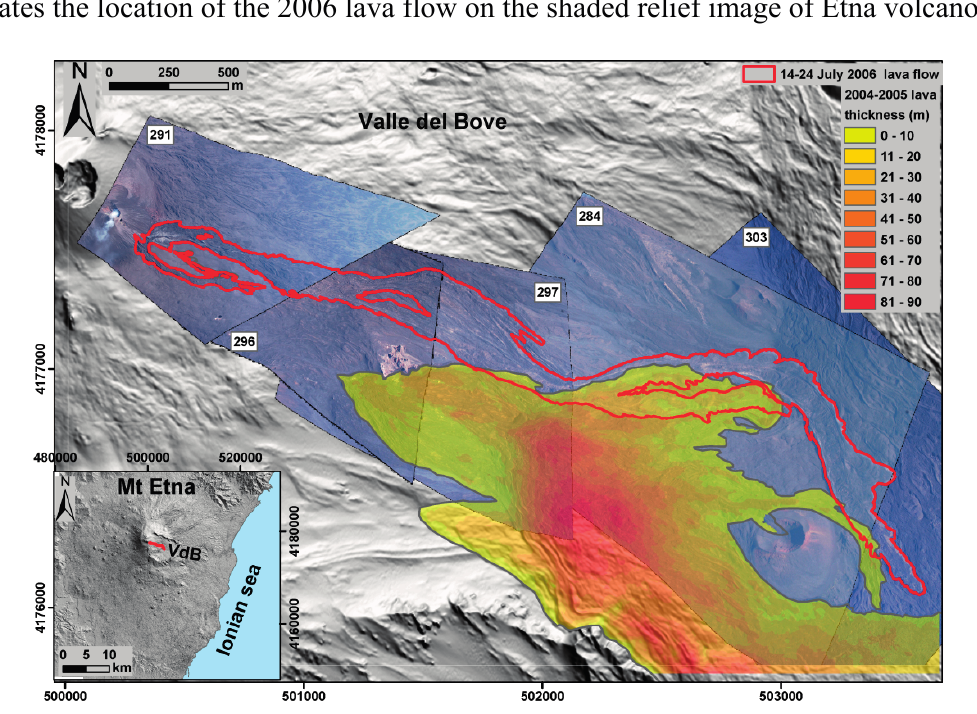
Figure 7. Test 2—2006 lava flow in Valle del Bove (Mt Etna): view of orthorectified images showing the limits of the lava flow formed between 14 and 24 July 2006 (red line). The colored map represents the area and the thickness of the 2004–2005 lava field. The inset indicates the location of the 2006 lava flow on the shaded relief image of Etna